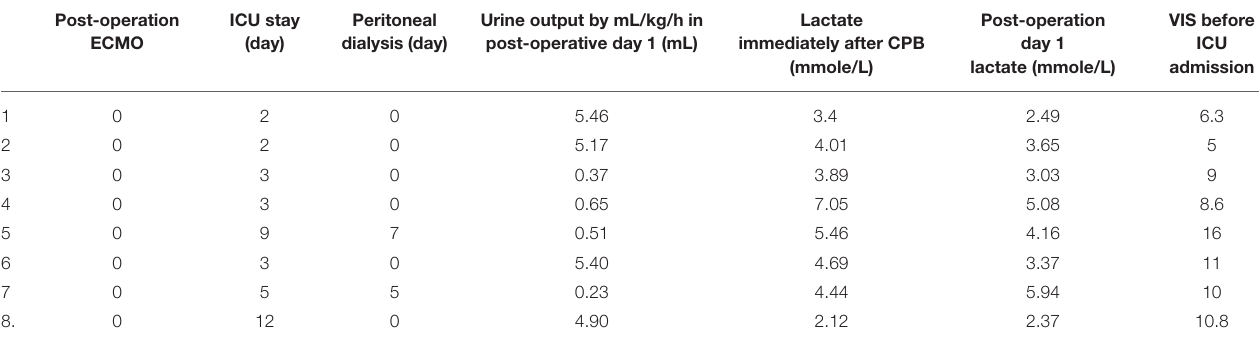
TABLE 2 | Clinical outcomes for included patients. Post-operation ECMO